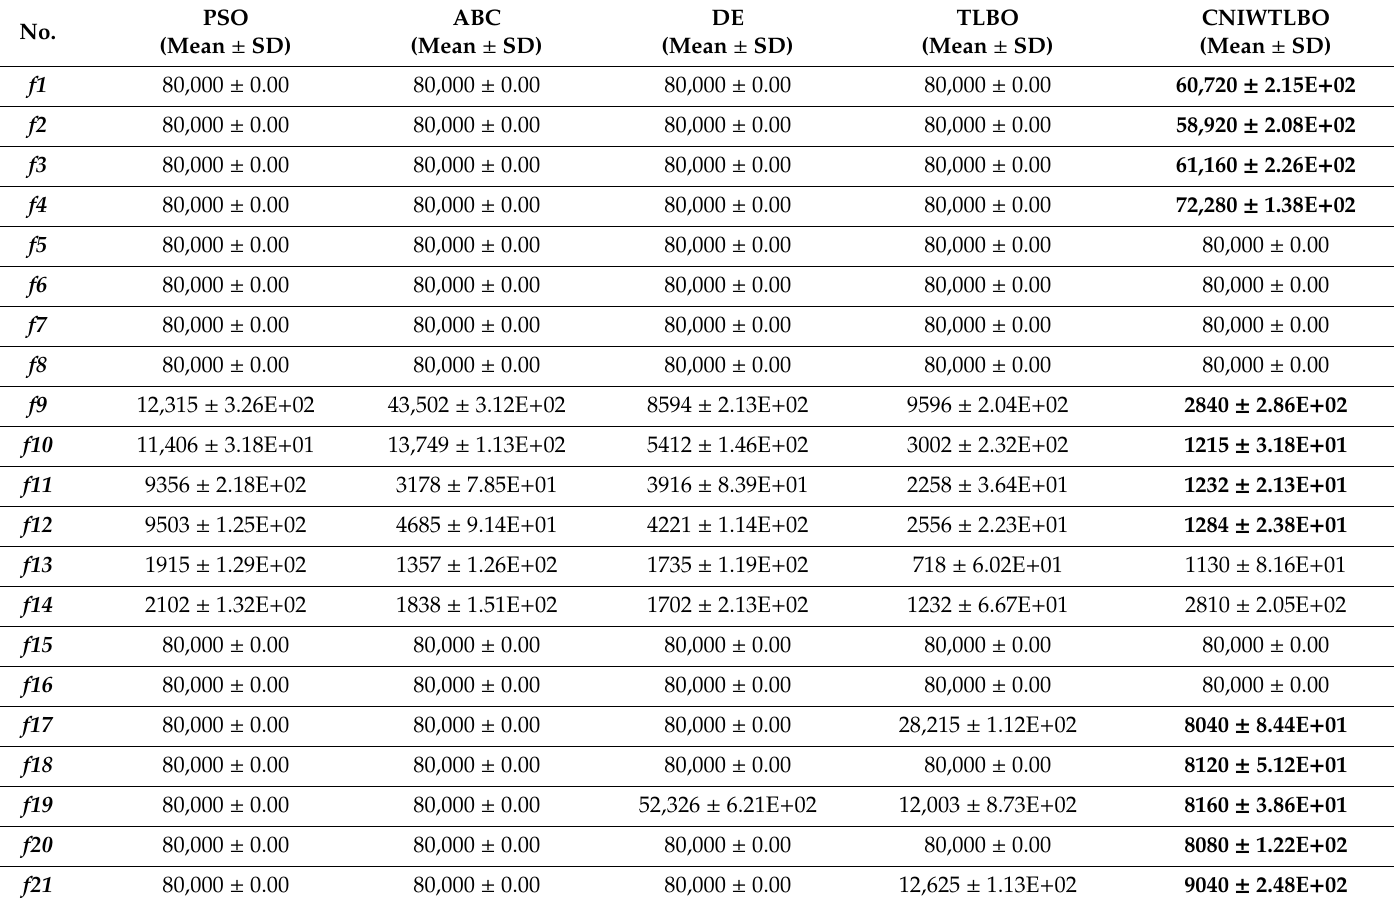
Table 4. Convergence comparisons in term of fitness